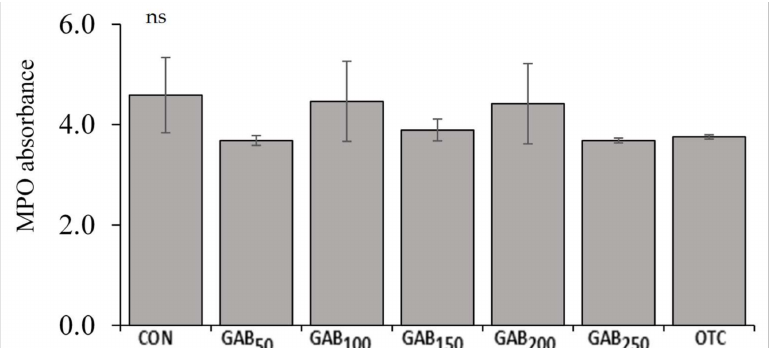
Figure 6. Serum myeloperoxidase (MPO) activity in juvenile olive flounder fed increasing levels of GABA. Values are mean of triplicate samples. See Table 1 for information on diets: CON, GAB 50 , GAB 100 , GAB 150 , GAB 200 , GAB 250 , and OTC.